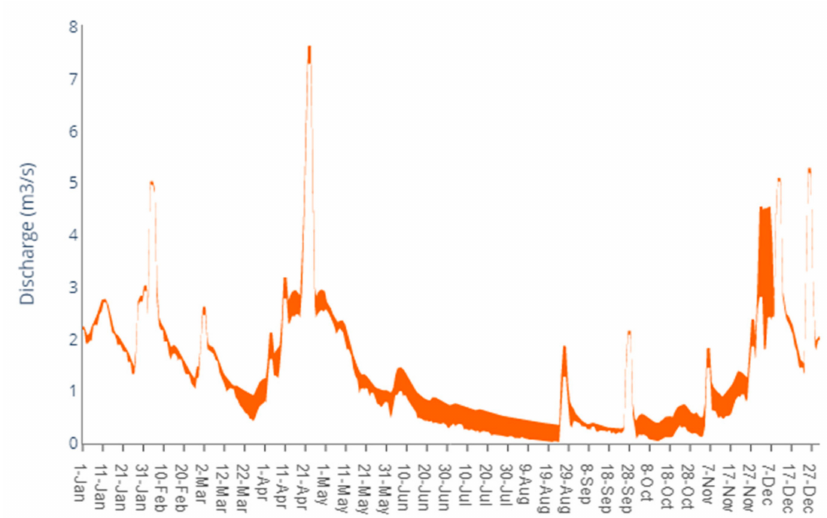
Figure 11. Flow series showing the magnitude of gap of the daily optimized diverted discharges with respect to the natural discharge for the DP1 under the dry scenario. Greater thickness indicates the highest trade-off between the natural discharge and water for municipal